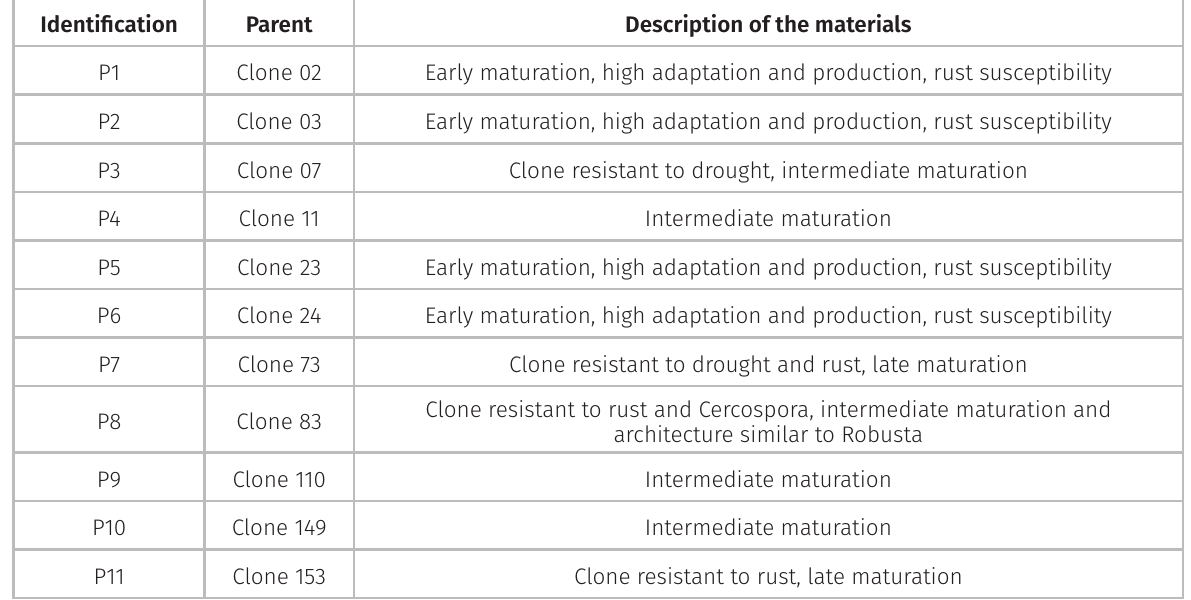
Table I. Parents used in the diallel crosses in the genetic breeding program of Incaper.